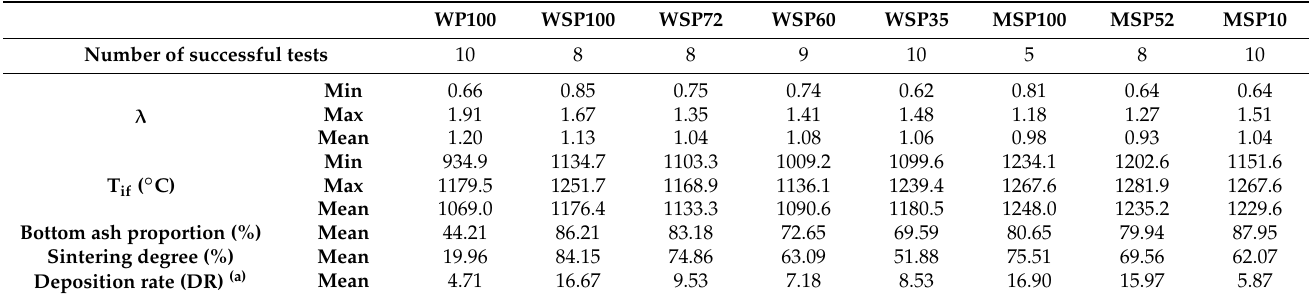
Table 2. Summary of reactor test